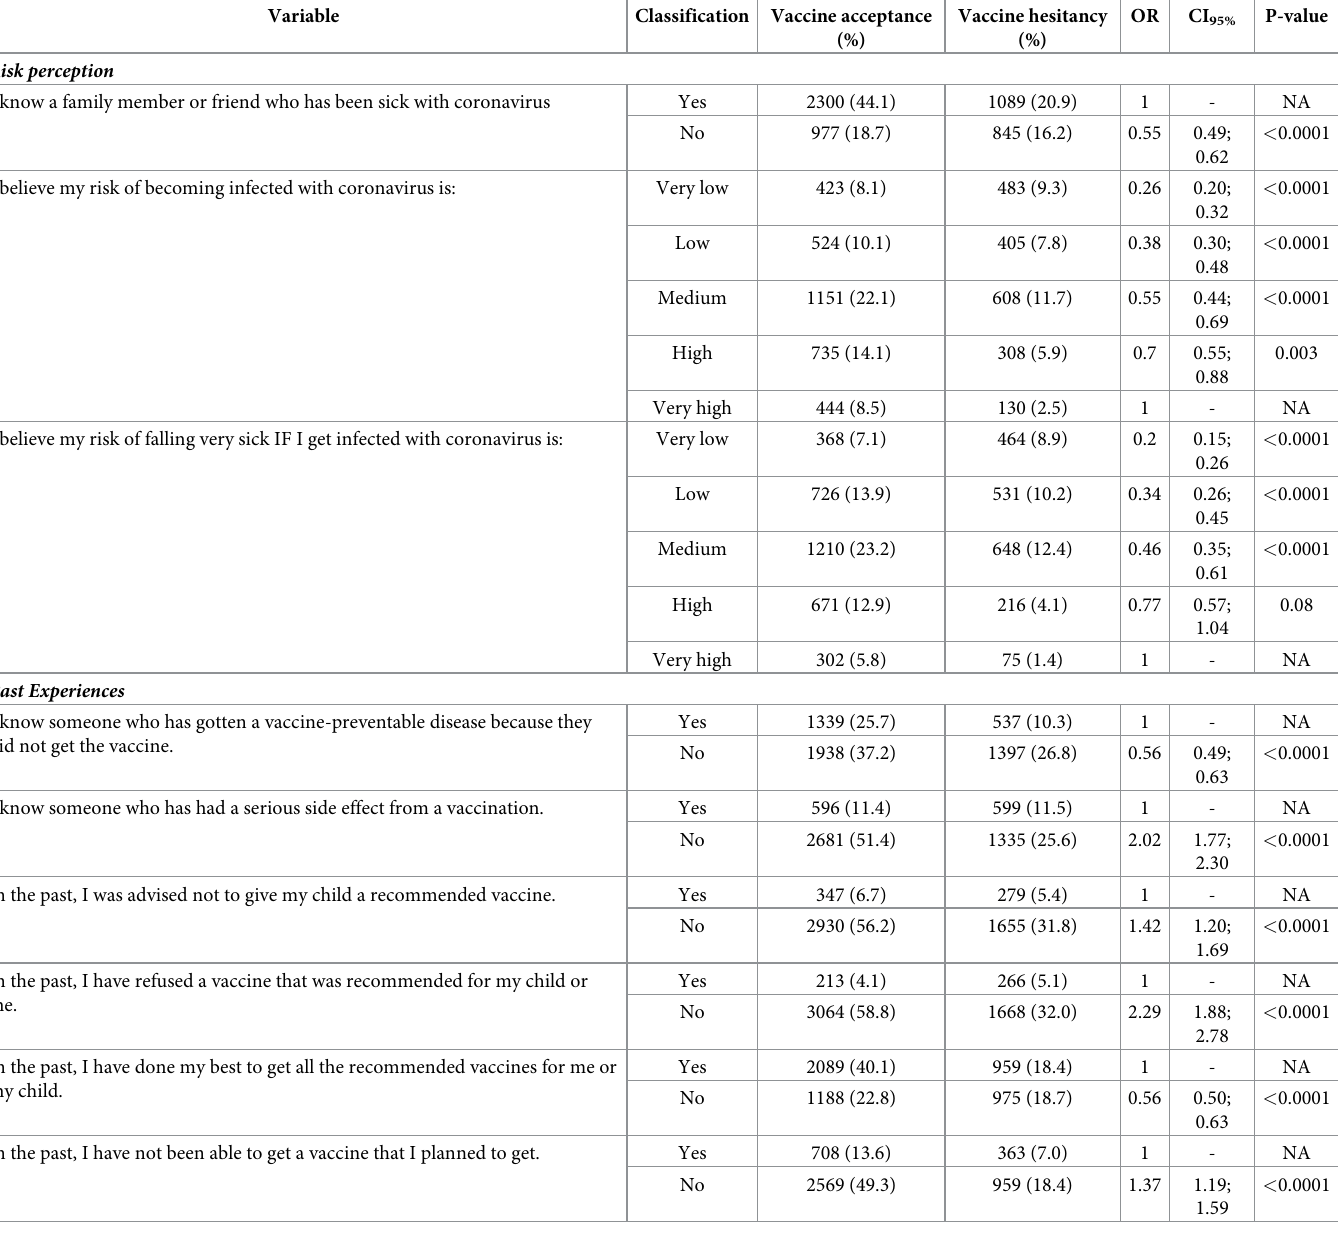
Table 3. Risk perception, past experiences and COVID-19 vaccine